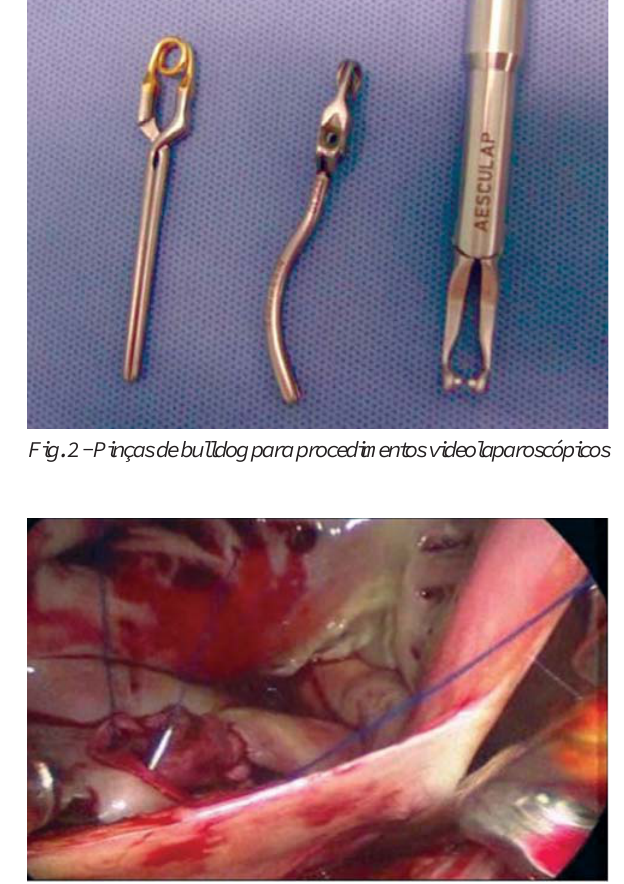
Fig. 3 - Fechamento da comunicação interatrial (CIA)